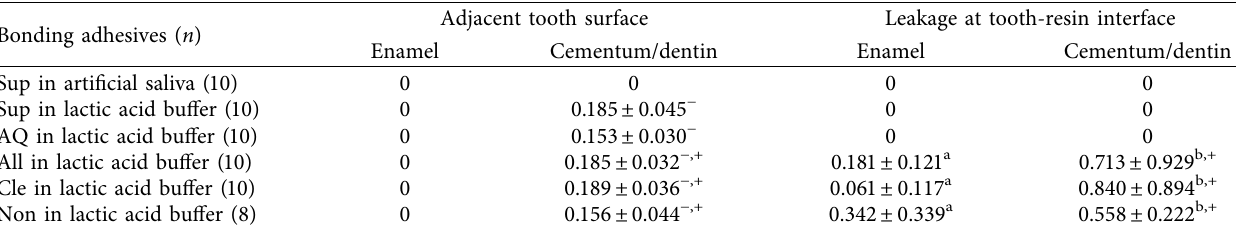
Table 2: The distance of dye penetration into the adjacent tooth surface and the leakage at the tooth-resin interface for all groups (mean ± SD in mm).